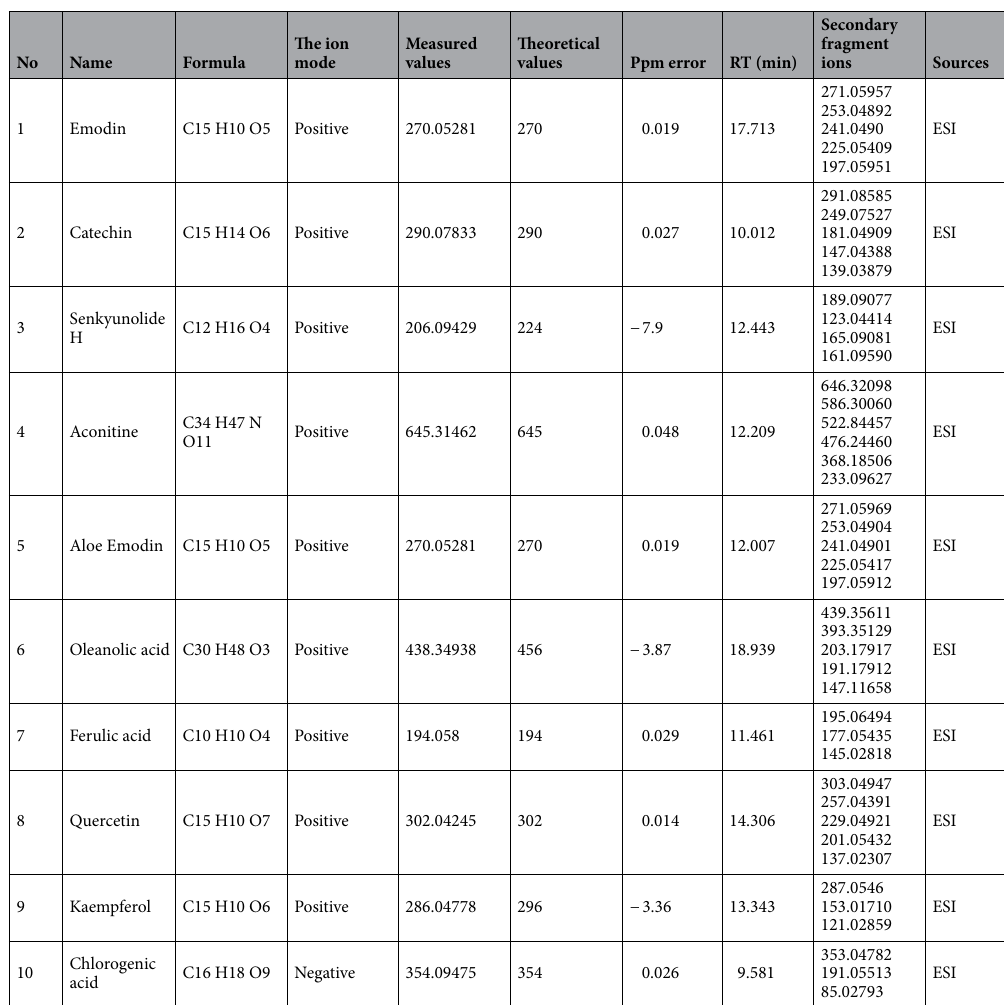
Table 1. Compounds identified through structural